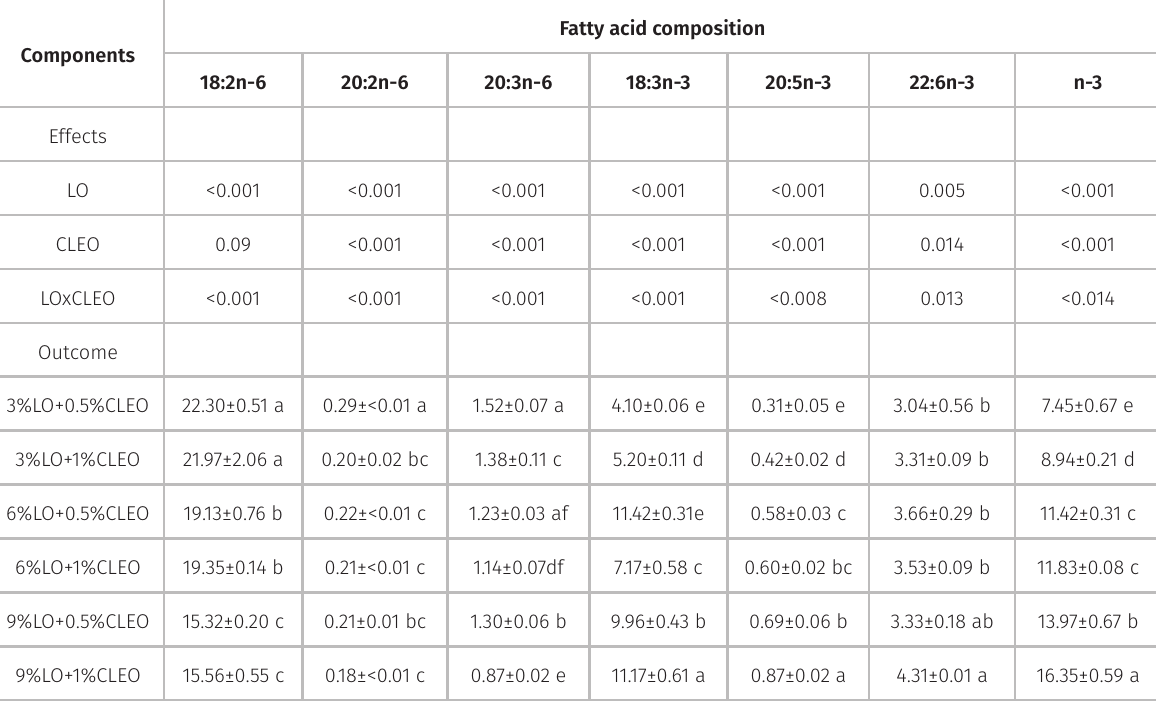
Table V. Effect of the experimental diets on the profile of fatty acids (% of the total) in the zebrafish muscle (